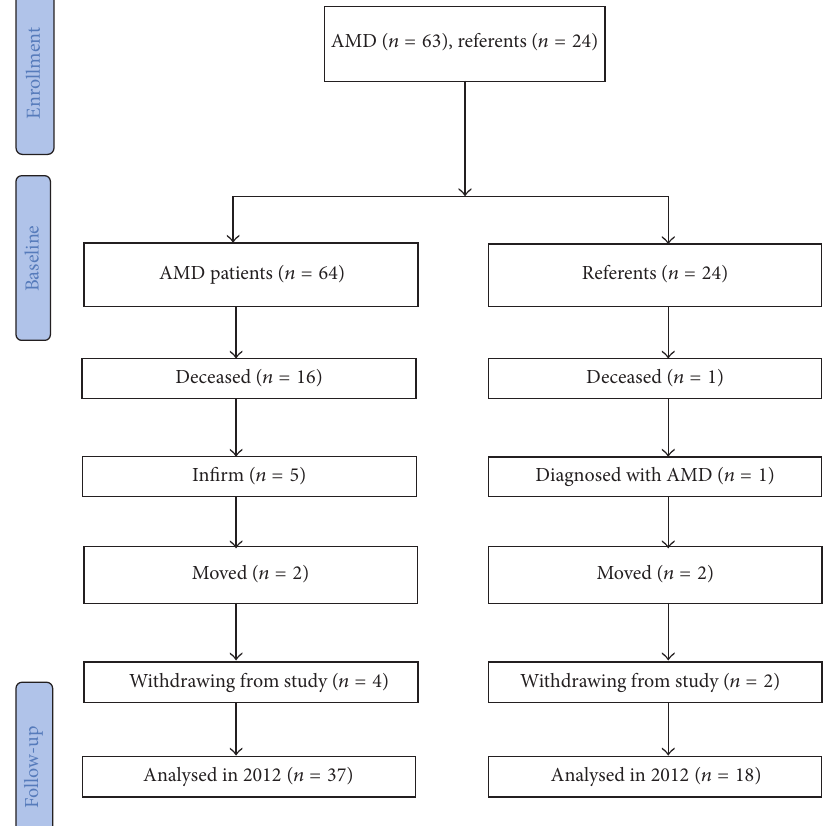
Figure 1: Consort chart showing number of allocated cases and controls at baseline and motives for not participating in follow-up approximately 3.8 years